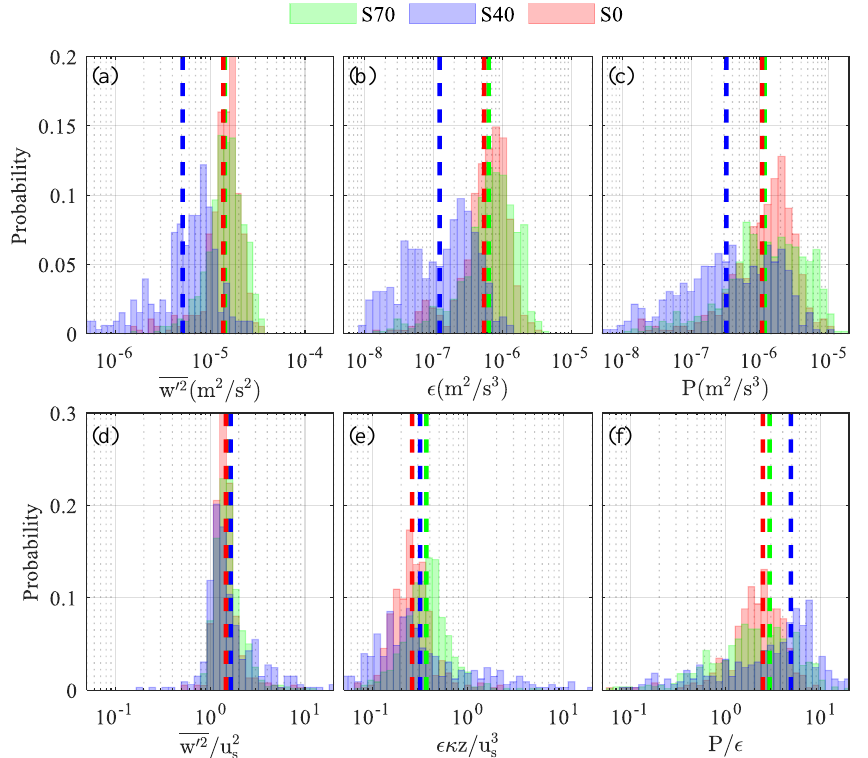
Figure 5. Regular ( a – c ) and normalized ( d – f ) turbulence characteristics observed at the S70 (green), S40 (blue), and S0 (red) sample sites. Turbulent energy ( a , d ; 𝑤 ′2 ̅̅̅̅̅ ) and turbulent kinetic energy (tke) dissipation rates ( b , e ; 𝜖 ) were normalized by the local turbulence velocity scale ( 𝑢 𝑠 ) and bed-distance length scale ( 𝜅𝑧; 𝜅 = 0.41 ) , while tke shear production ( c , f ; 𝑃 ) was normalized by the measured tke dissipation rate.